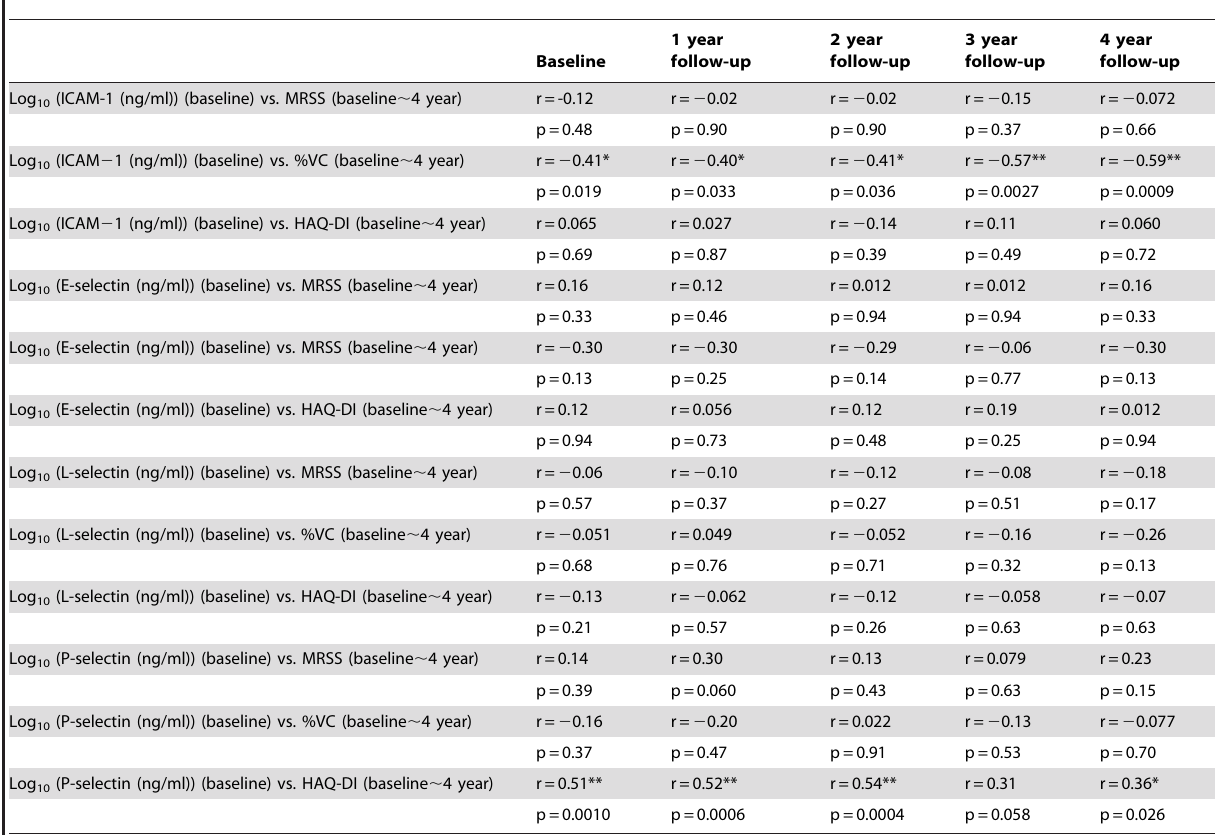
Table 2. The associations between baseline adhesion molecule levels and subsequent clinical parameters in patients with SSc.